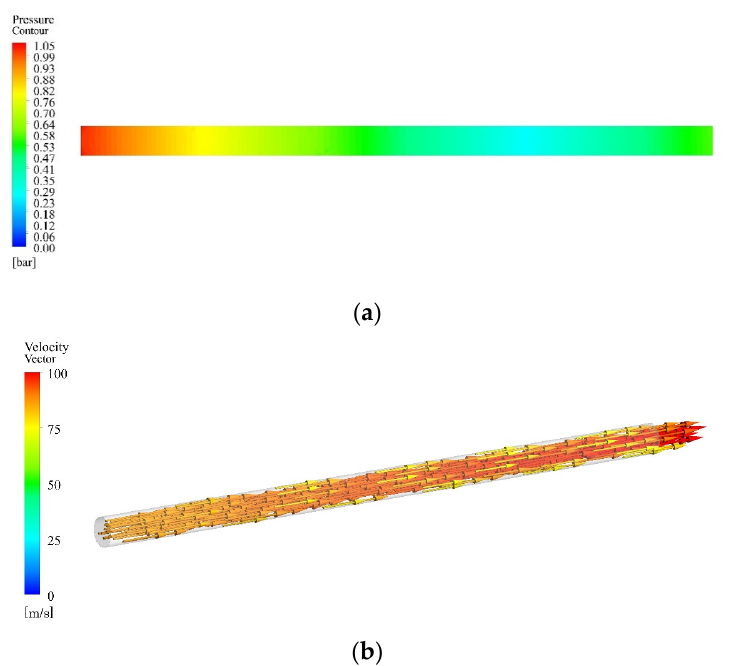
Figure 7. Flow characteristics results of the 1D–3D approach numerical analysis in the straight pipe shape exhaust system: ( a ) pressure contour; ( b ) velocity vector.